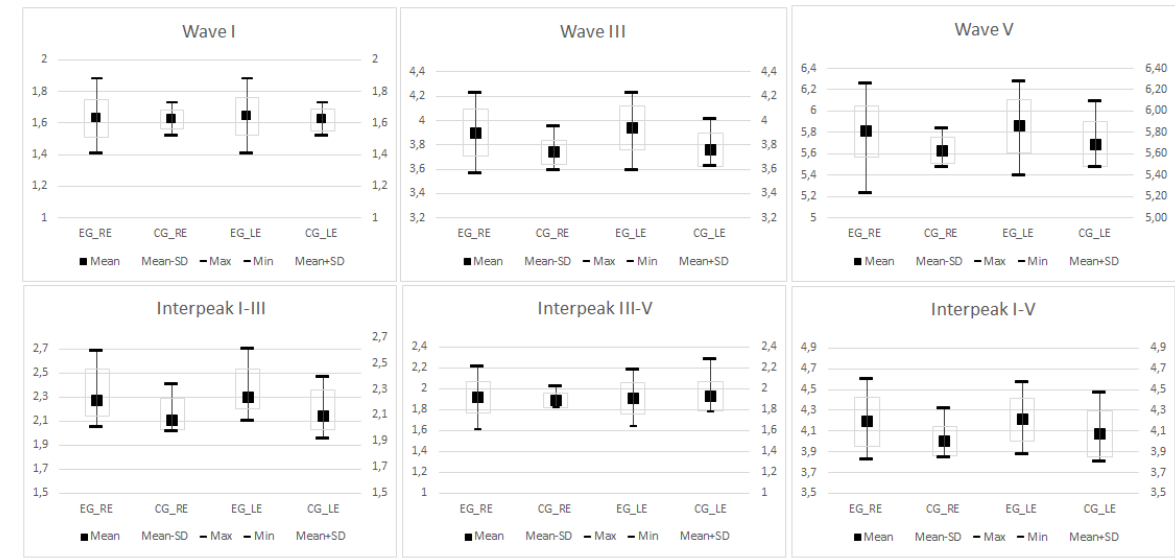
Figure 2. Boxplots of the mean, standard deviation, and maximum and minimum values of the absolute and interpeak latencies of the BAEP, obtained in the right (RE) and left (LE) ears of the exposed (EG) and control (CG) groups, with pure-tone auditory threshold up to 25 dB HL at the frequencies from 2000 to 4000 Hz.